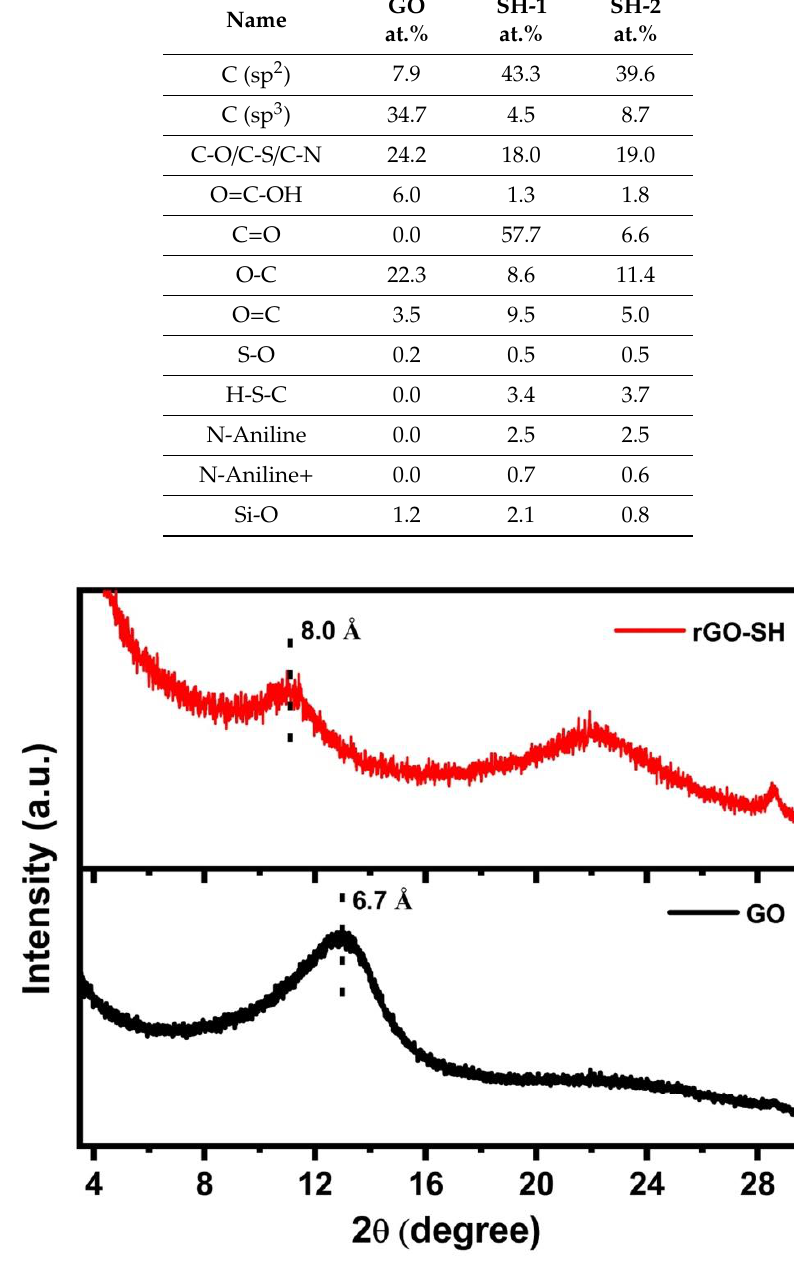
Figure 3. XRD patterns for the GO and rGO – SH samples. The basal plane d -spacing values are indicated on the plot.